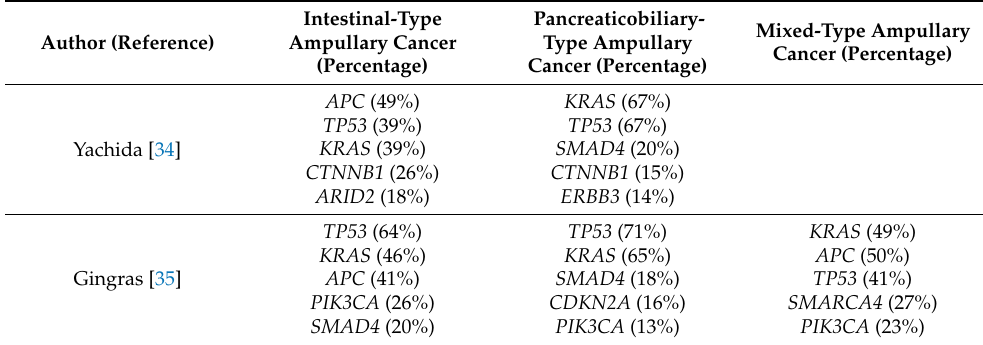
Table 1. The more frequently observed gene mutations in ampullary cancer, according to recent studies conducted by Yachida and Gingras